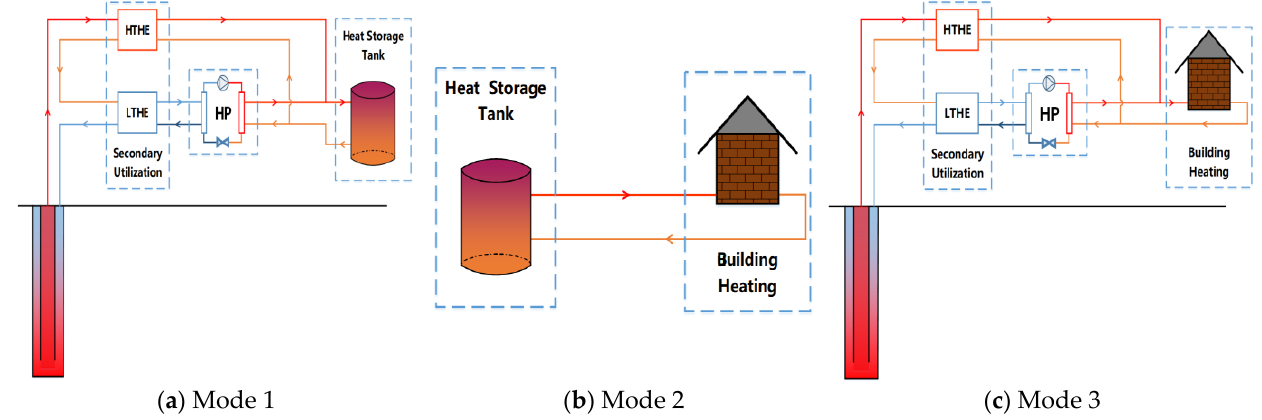
Figure 5. Schematic diagram of three operation modes: ( a ) water tank heat storage mode (Mode 1); ( b ) water tank heating mode (Mode 2); ( c ) conventional heating mode (Mode